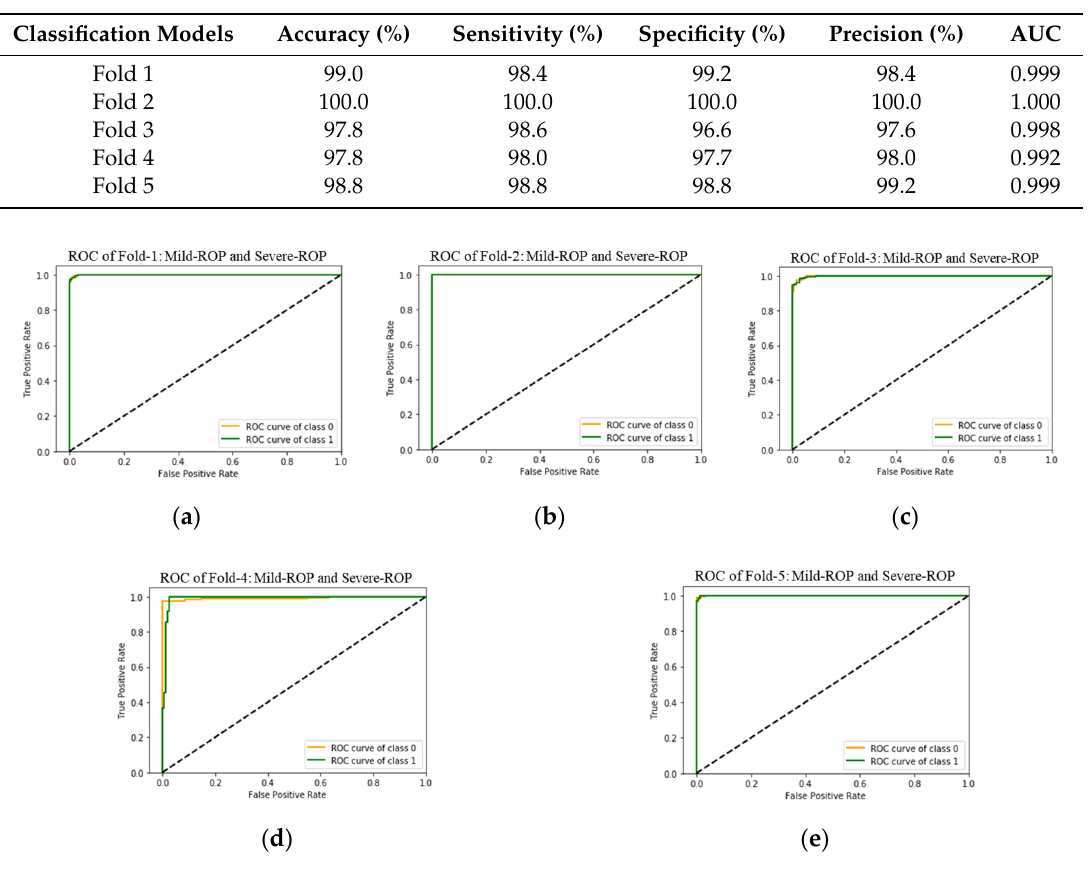
Figure 9. ROC curves for each of the 5 folds of data ( a–e ) obtained using the VGG19 classification model. The orange and green ROC curves in individual plots represent class 0 (mild-ROP) and class 1 (severe-ROP), respectively. Table 9. Performance evaluation of the 5-fold cross-validation of the VGG19 model.